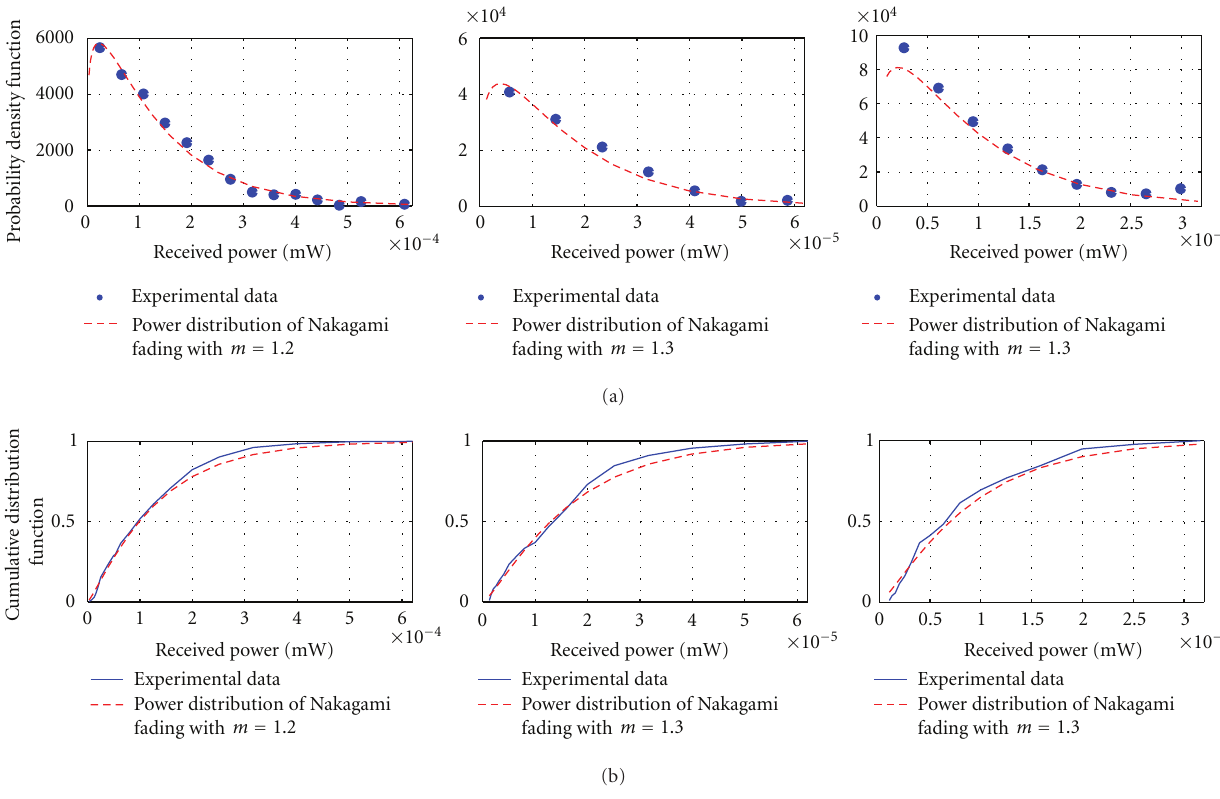
Figure 7: The distribution of small-scale fading using three di ff erent parts of our gathered measurements. Nakagami distribution shows a very good match—(a) pdf and (b)